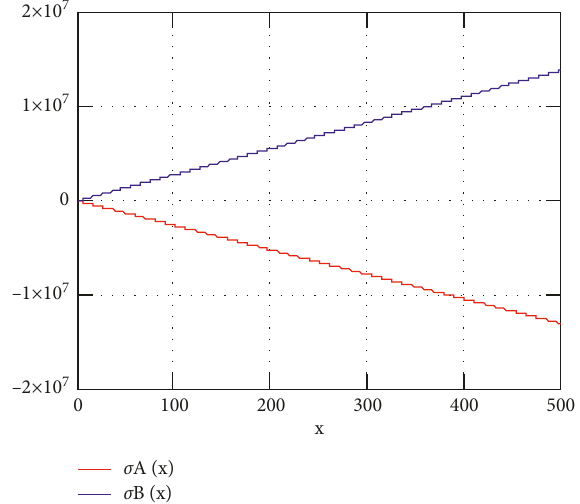
Figure 8: Displacement nephogram of the rock column under self- weight stress.